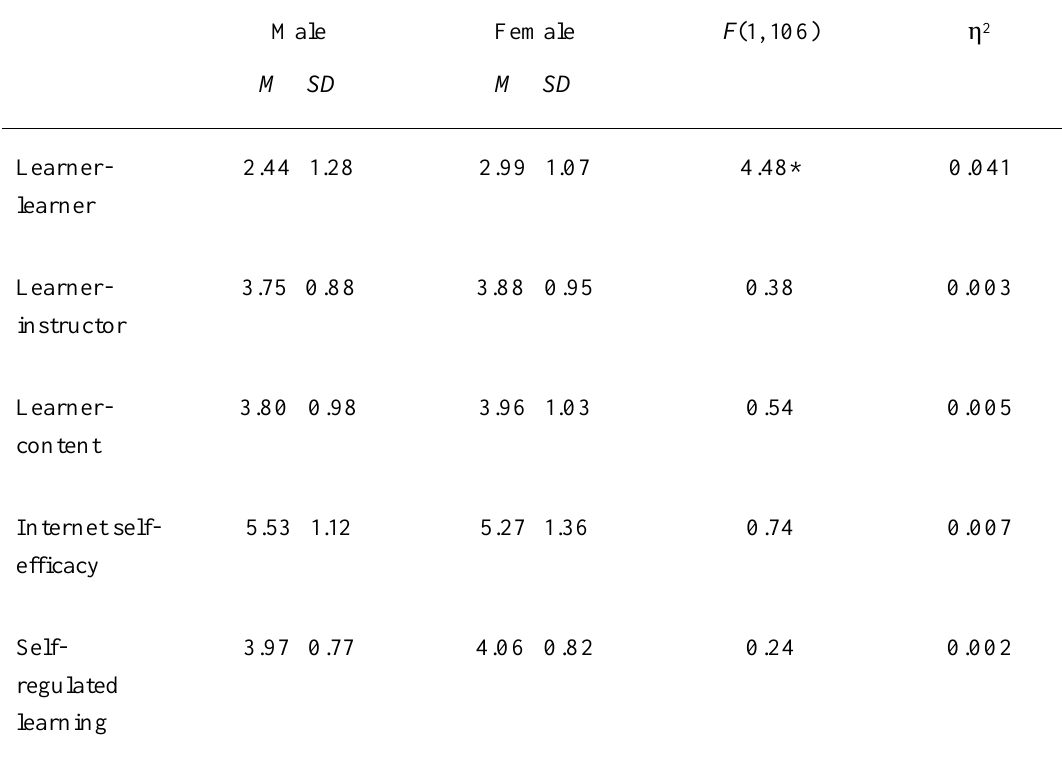
One-Way ANOVA of Gender on Predictor Variables Male M SD